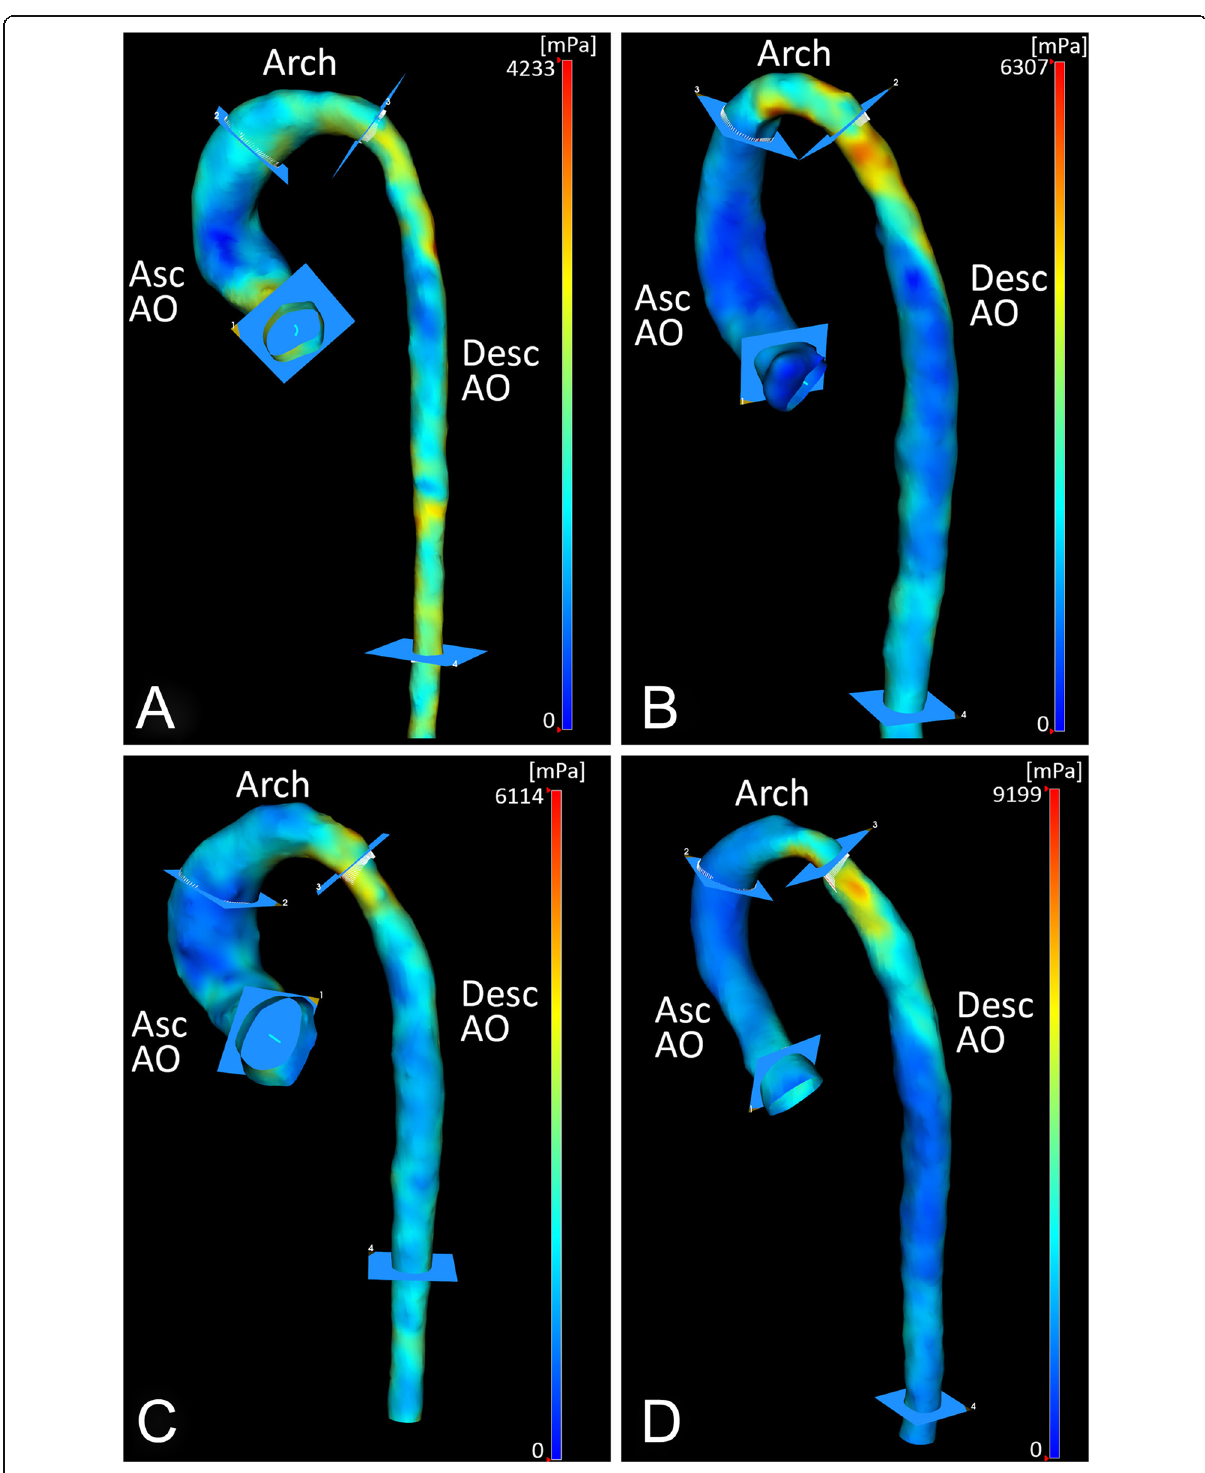
Fig. 3 Three-dimensional magnitude wall shear stress maps of patients with aortic coarctation subdivided on both the aortic valve morphology and the presence of reobstruction, incorporating the anatomical segments: Asc AO , ascending aorta; Arch , aortic arch; Desc AO , descending aorta. a Example of patient with tricuspid aortic valve without reobstruction. b Example of patient with tricuspid aortic valve with reobstruction. c Example of patient with bicuspid aortic valve without reobstruction. d Example of patient with bicuspid aortic valve with